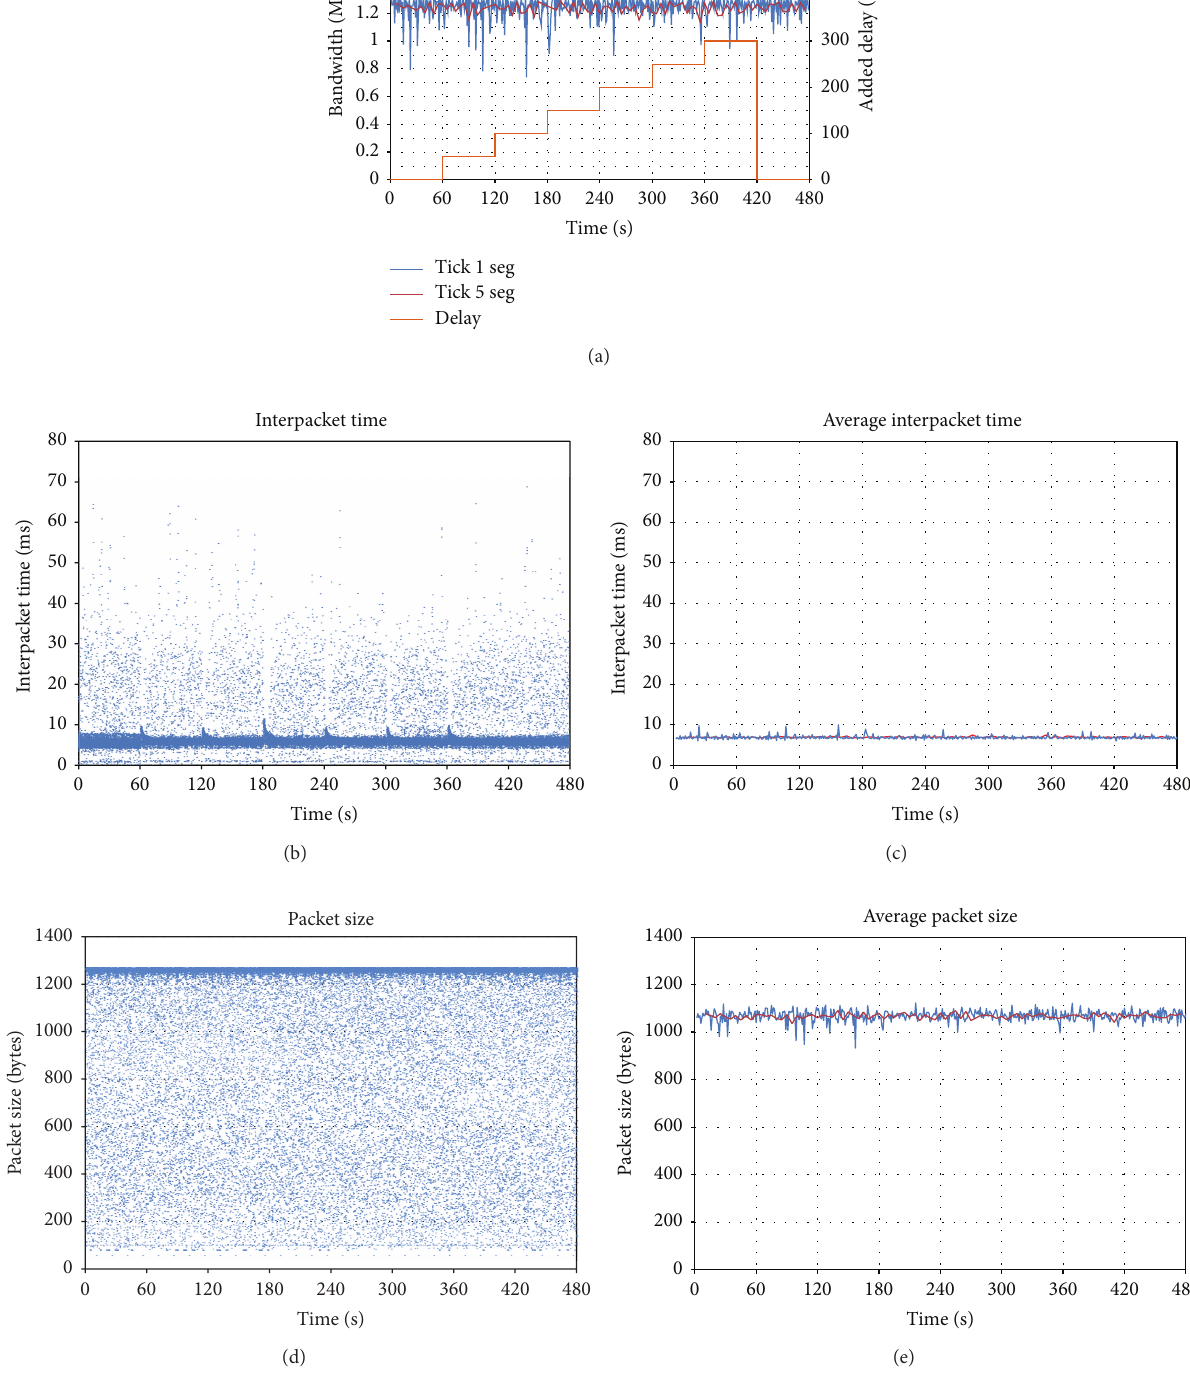
Figure 6: Effect of delay on Vidyo : (a) evolution of sent throughput; (b) interpacket time; (c) average interpacket time; (d) packet size; (e) average packet